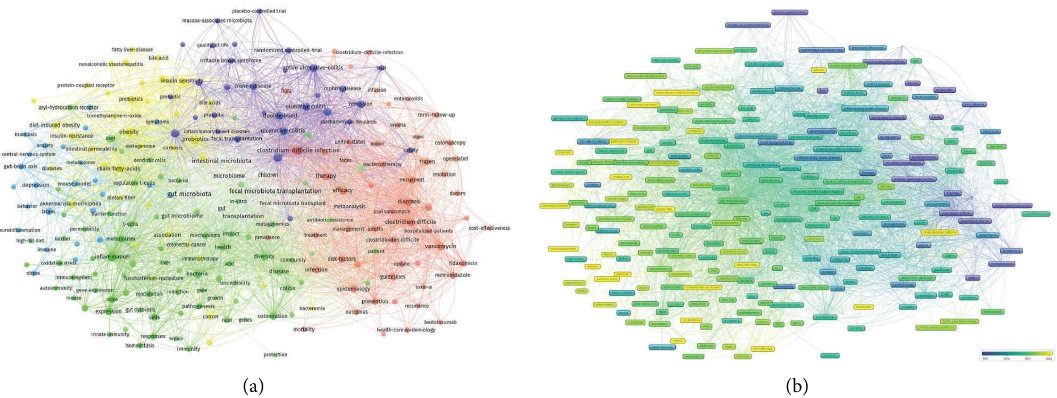
Figure 7: (a) Common keywords cluster analysis (various colors show various types, the circle’s size manifests the keywords frequency, and line’s width manifests the link intensity). (b) Common keyword evolution trend over time (the blue and yellow boxes show the earlier and latest keywords, respectively).